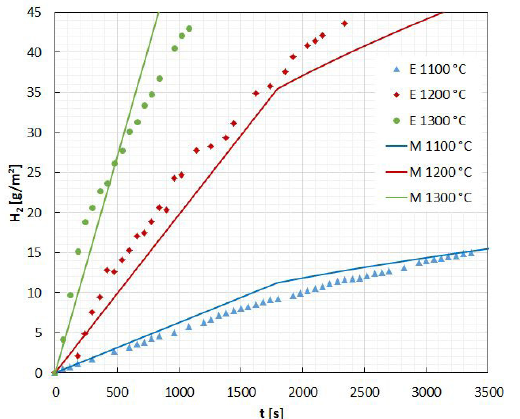
Figure 12. Evolution of the hydrogen generation curves for AISI 348 at 1100 °C, 1200 °C, 1300 °C in water, comparing typical experimental results (E) with the linear parabolic model (M).